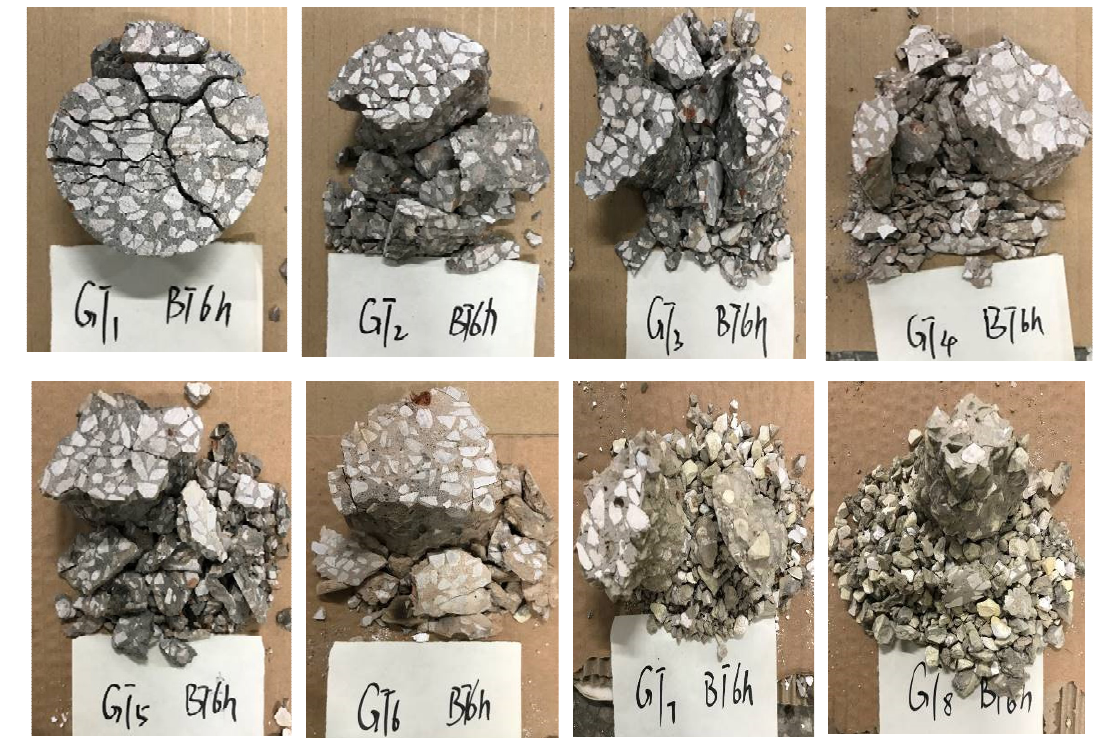
Figure 7. Fracture patterns of HPC specimens after impacts at different temperatures.